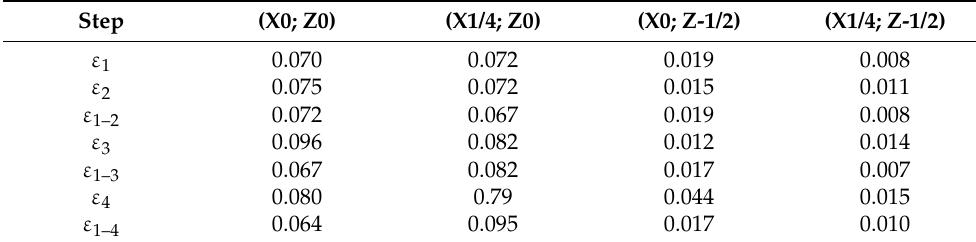
Figure 6. Dynamic deformation of a CFRP specimen with four QRS located below the center span (identification X0), or in the middle along the side of the specimen (X1/4), and one ply below the surface (Z0) or near the neutral axis (Z-1/2). ( a ) Four stages of increasing strain applied to the specimen and the reference strain periods/plateaux. The inset represents a magnification of the sinusoidal load applied to the sample during the test. In each sections, the sample is subjected to a dynamic sinusoidal bending load of a small amplitude (+/ − 0.06) around a fixed value ( ε 1 , ε 2 etc.). ( b ) Average value of the relative electrical amplitude of QRS in the four increasing steps. The scale bars represent the amplitude of the dynamic response. ( c ) Average value of the relative amplitudes of the QRS during reference periods of low strain. The scale bars represent the amplitude of the dynamic response to a small variation of +/ − 0.06% around a fixed ε i value. Table 2. QRS response amplitude during the cycling steps .